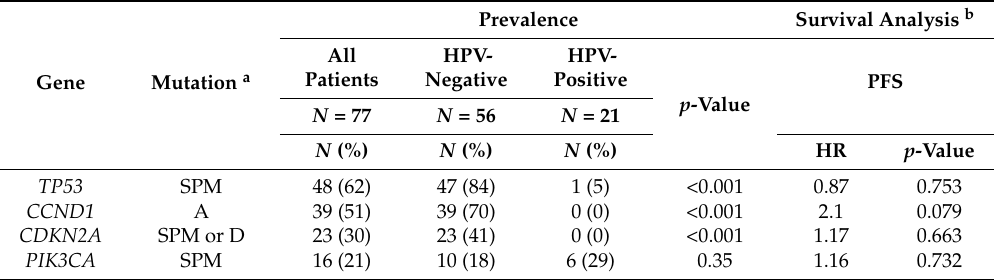
Table 2. Prevalence of selected driver gene mutations and association with progression free survival